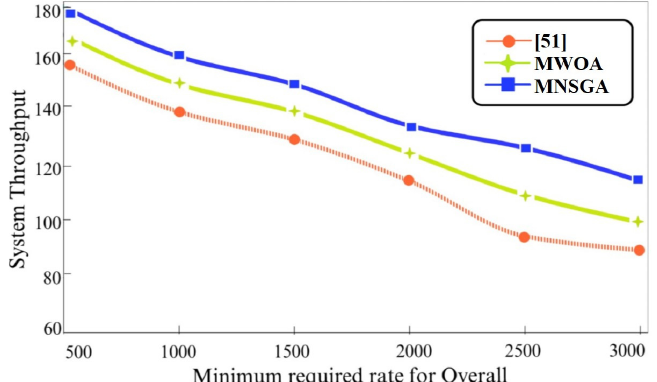
Figure 14. Overall throughputs for minimum distance between D2D pairs.